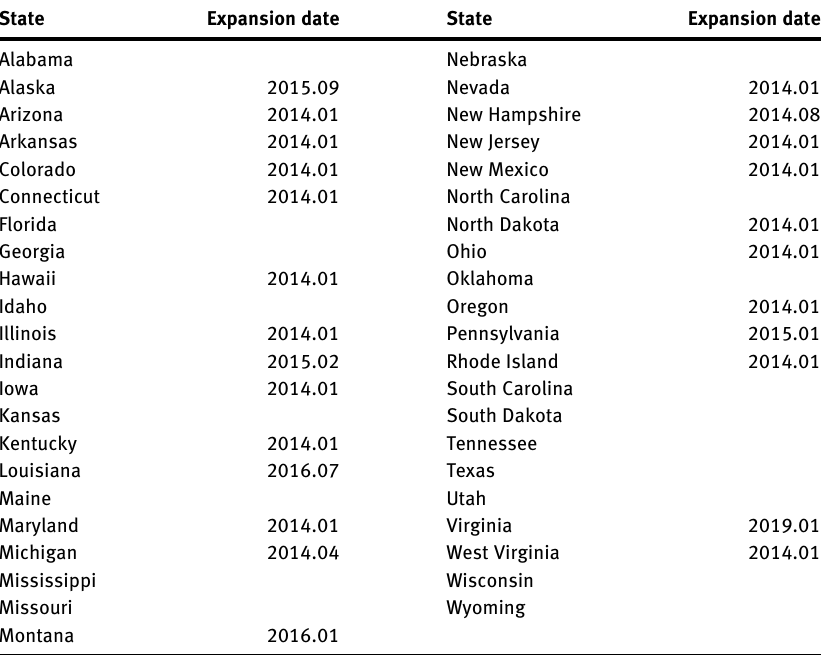
Table A  : Adoptions of Medicaid